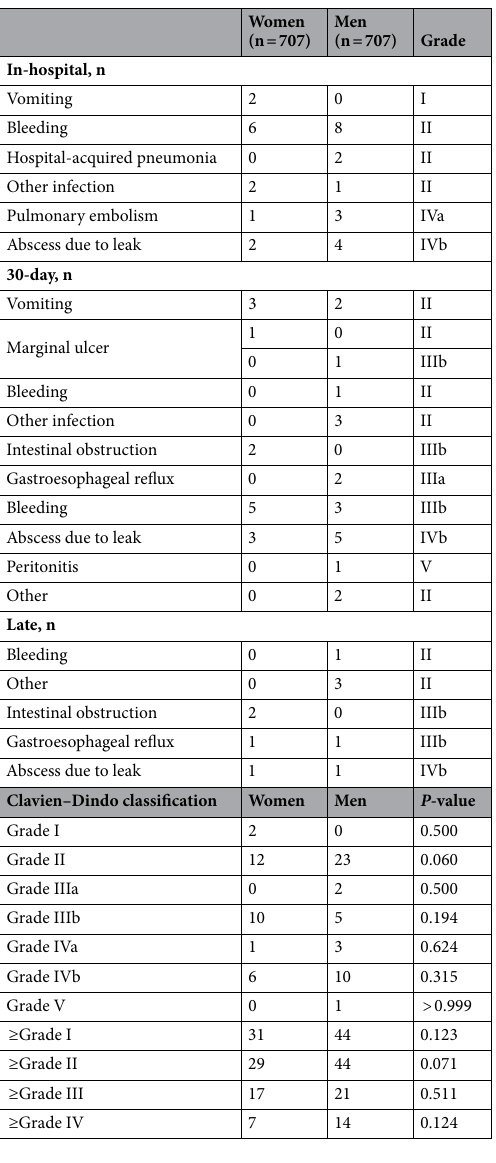
Table 4. Matched comparison of postoperative complications between men and women according to the Clavien–Dindo